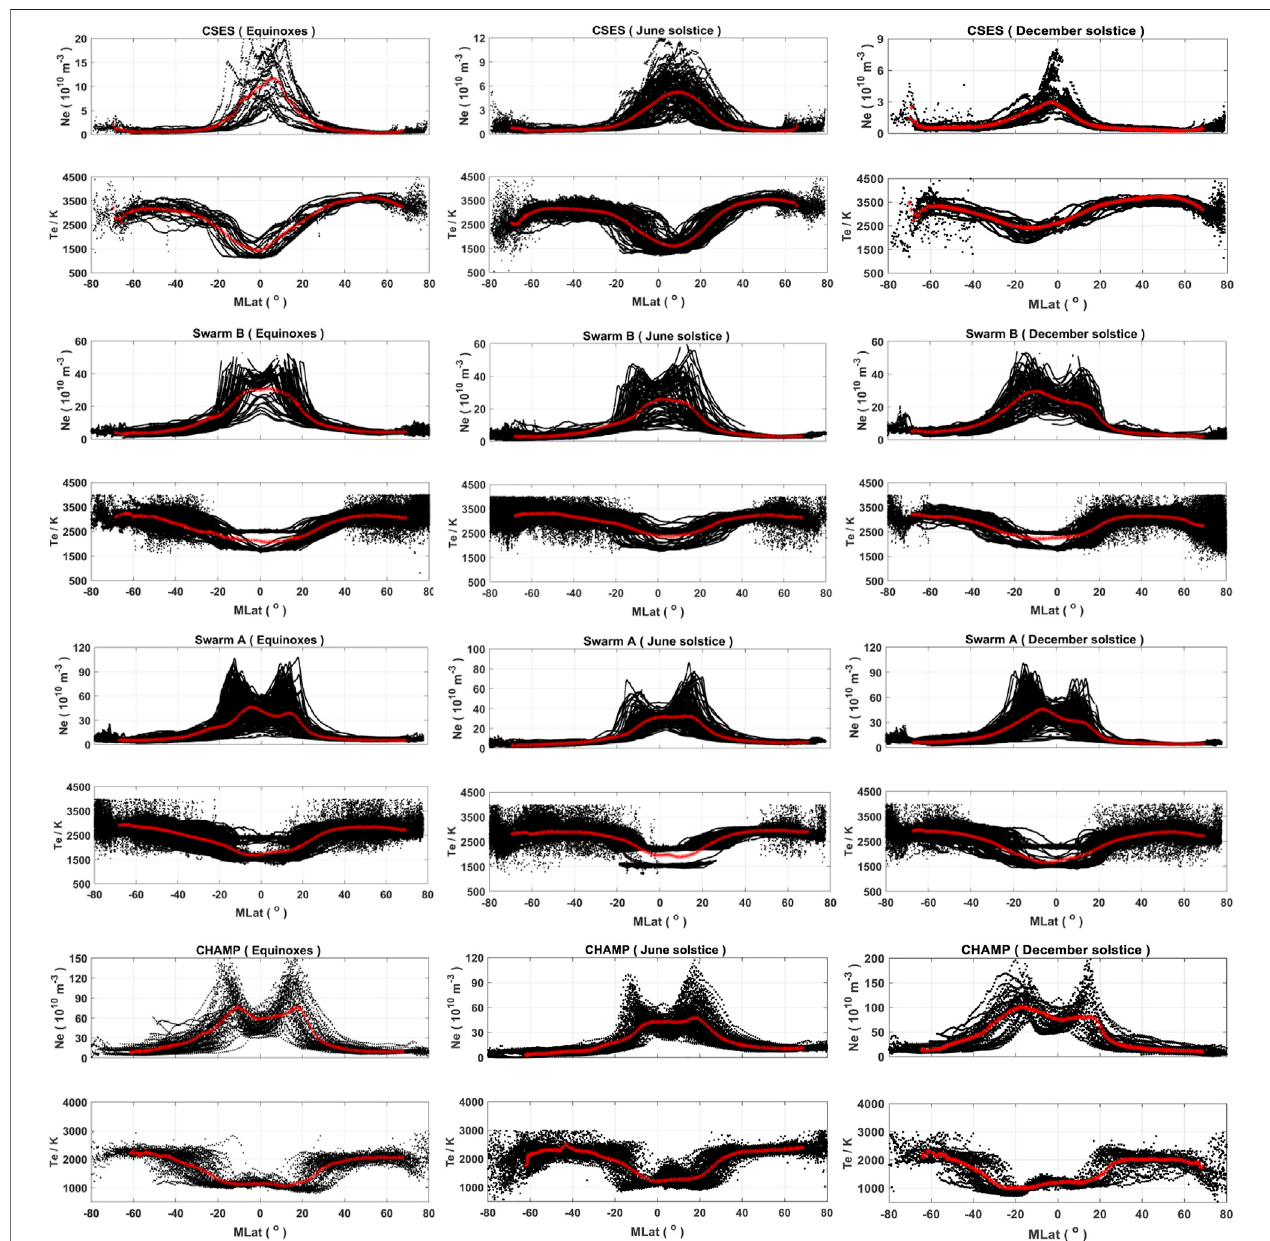
FIGURE2| TheMLat distributions of Ne/Te pro fi les ofCSES, Swarm B,Swarm Aand CHAMP (from toptobottom). Theequinoxes, Junesolstice, and December solstice are shown in columns from left to right. The red lines represent the average pro fi le of each season.